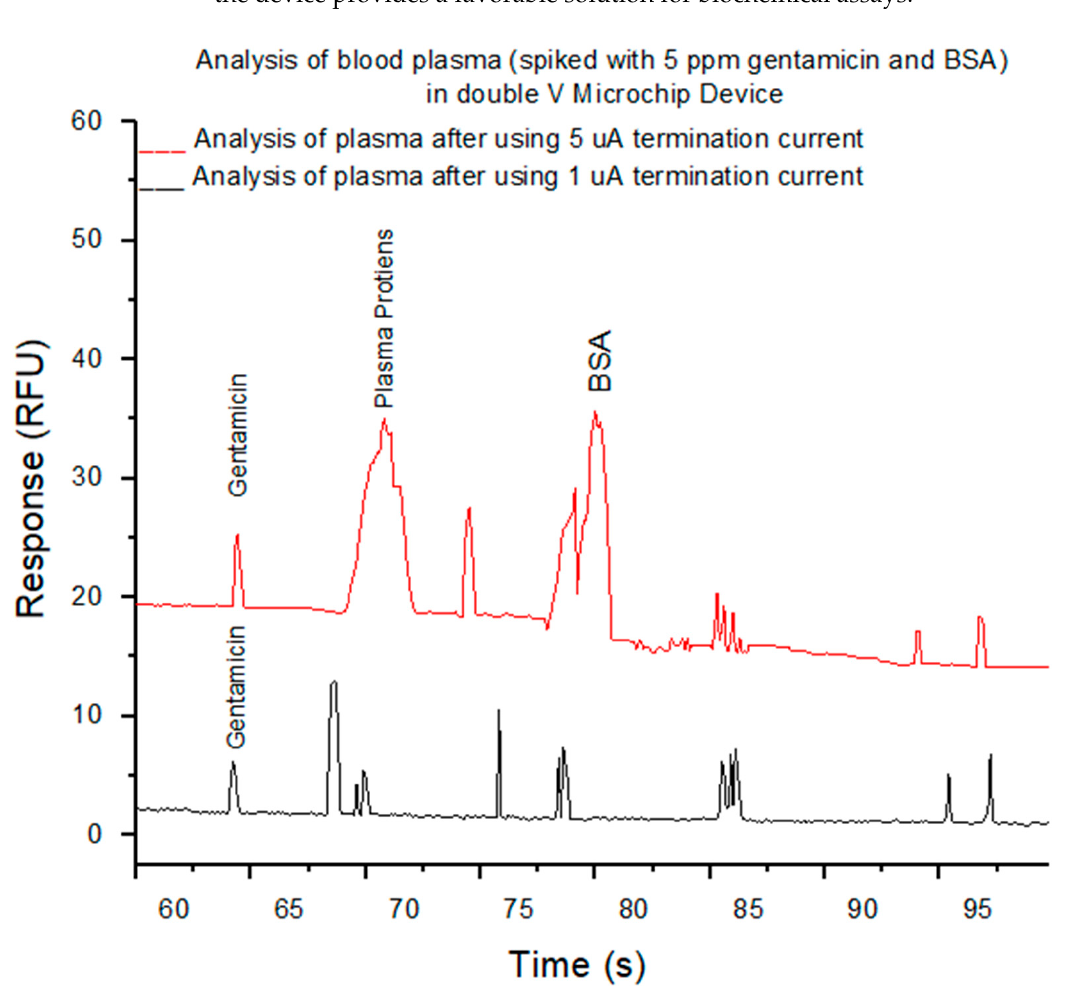
Figure 4. Electropherograms show the analysis of filtered blood spiked with 5 ppm gentamicin and BSA after labeling with fluorescamine in size and mobility trap (SMT) device after using a current limit of 5 uA (red trace) and 1uA current limit (black trace). The background electrolyte (BGE) in the separation channel, was 100 mM phosphate buffer, pH 11.5, with 0.5% HPMC, while V-sample waste channel was 10 mM phosphate buffer, pH 11.5. Applied voltages used in SMT device for extraction and concentration were − 200, − 850, − 600, and +650 V for 60s, and separation process were − 250, +250, +2200, and − 500 V at reservoirs B, S, BW, and SW, respectively.